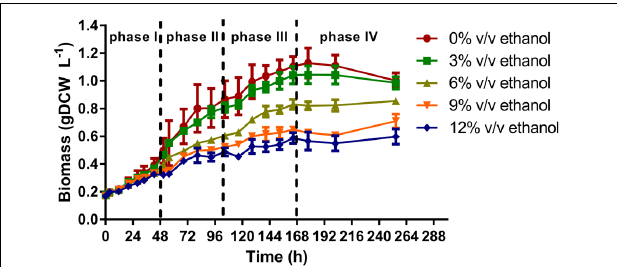
FIGURE 2 | Effect of ethanol concentration on the growth of O. oeni PSU-1 strain cultivated in MaxOeno, a defined wine-like culture medium. Each growth phase is delimited by discontinued vertical lines. Phases I, II III, and IV last between 0 to 48 h, 48 to 104 h and 104 to168 h and 168 to 264 h of cultivation, respectively.